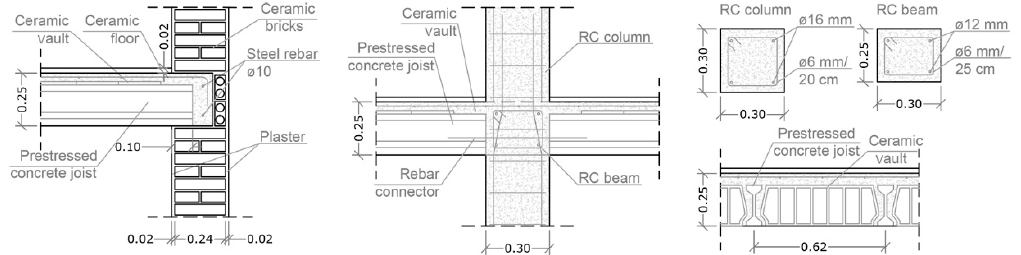
Figure 4. Constructive and structural details of the building.